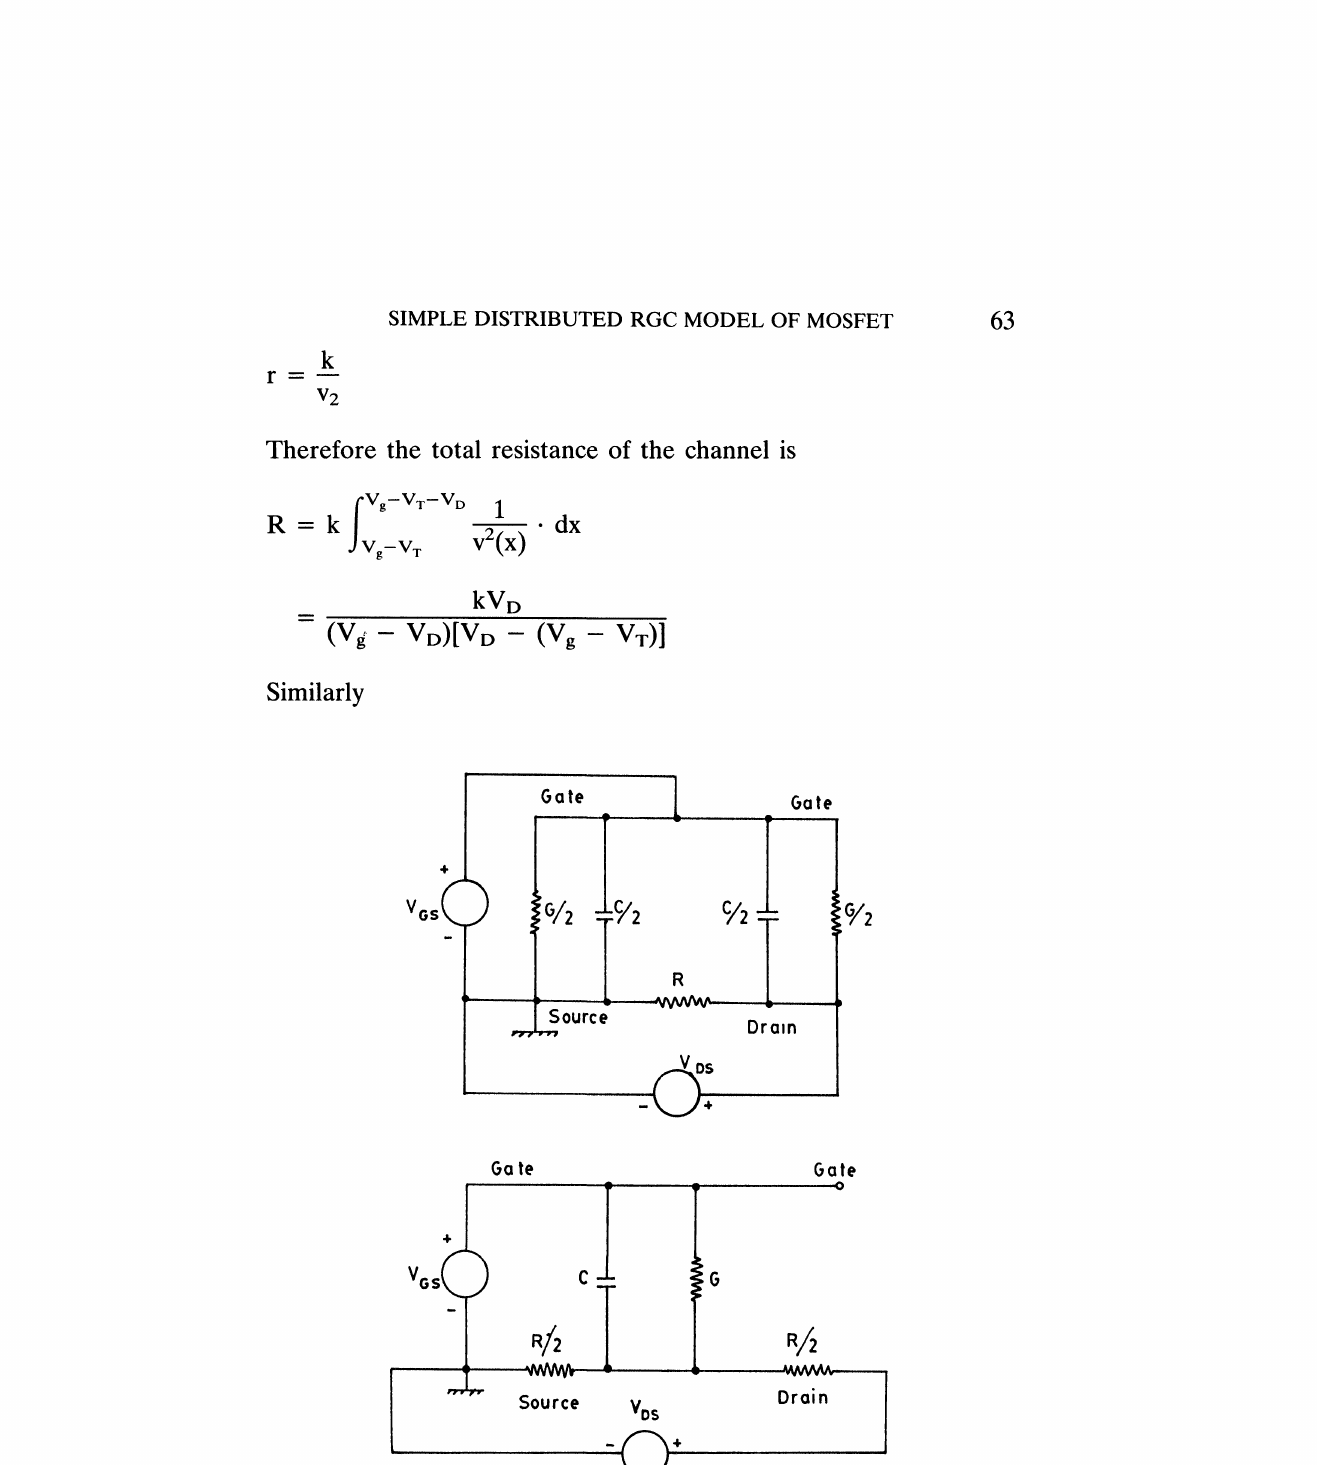
FIGURE 4 Single section models of